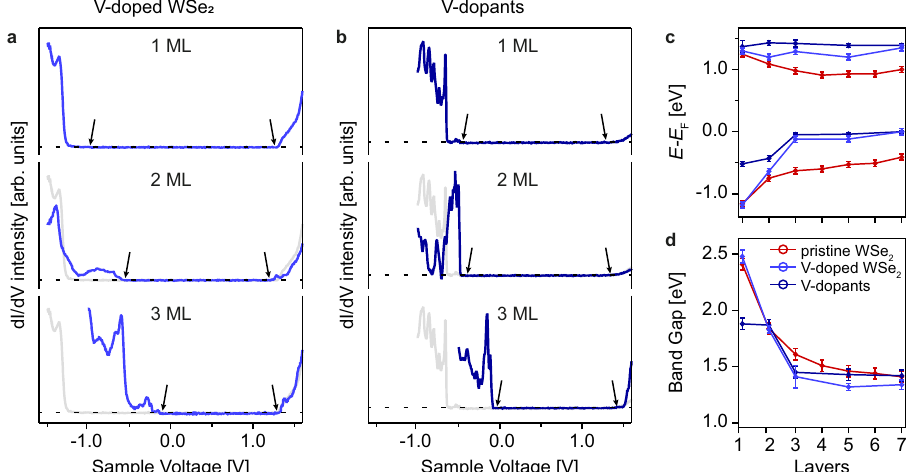
Fig. 4 Layer-dependent electronic properties of V-doped WSe 2 . a , b STS recorded for 1 – 3 ML of V-doped WSe 2 ( a ) and of V dopants ( b ) in the topmost WSe 2 layer (blue). The gray lines display the 1 ML data for comparison. The black arrows indicate the positions of the valence and conduction band edges for V-doped WSe 2 and of the localized dopant state and the conduction band edge for V dopants. c , d